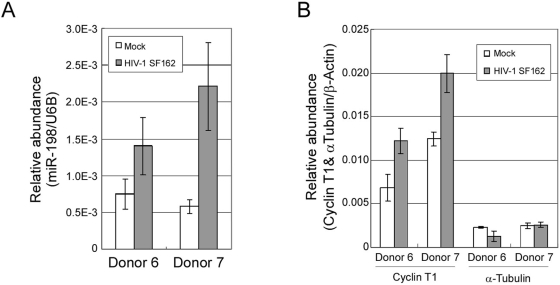
HIV-1 infection of primary macrophages affects miR-198 as well as Cyclin T1 mRNA levels.Macrophages were infected with HIV-1 SF162 strain for seven days and total RNA was isolated and assayed for: (A) expression levels of miR-198; (B) Cyclin T1 and α-tubulin mRNAs. U6B snRNA was used for normalization of miR-198 and β-actin mRNA was used for normalization of mRNAs. Bars represent the range in the three measurements.